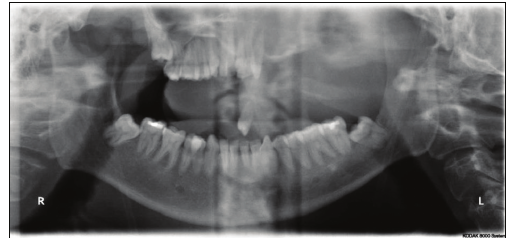
Figure 4: OPG showed erosion of the left maxilla and downward displacement of 24.